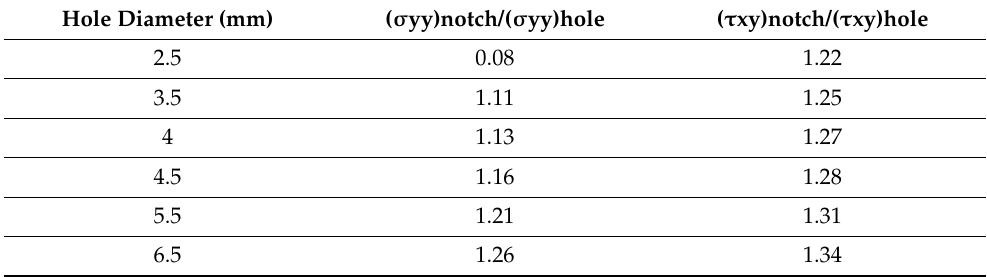
Figure 26. Stress concentration, as computed by a FEA at p = 8 at a notch ( a , c ) and at a hole ( b , d ) for the different predicted stresses: ( a , b ) σ yy , ( c , d ) τ xy . Table 10. Ratios of the notch/hole transverse and shear stresses for different holes diameter.